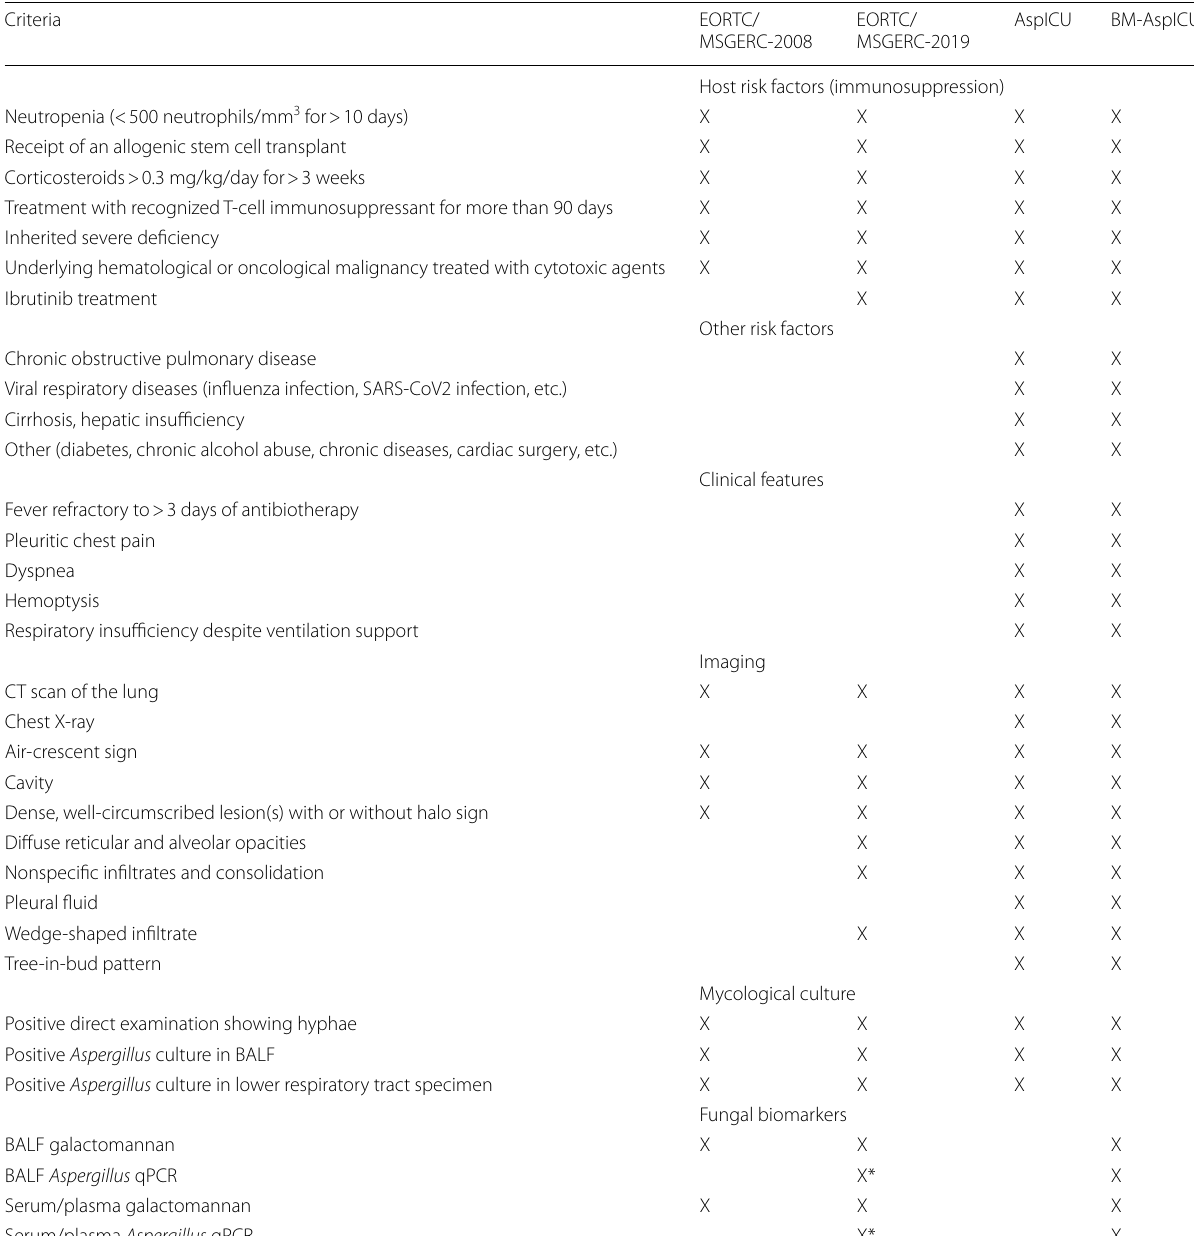
Table 1 Diagnostic criteria for invasive pulmonary aspergillosis according to EORTC/MSGERC‑2008, EORTC/MSGERC‑2019, AspICU and